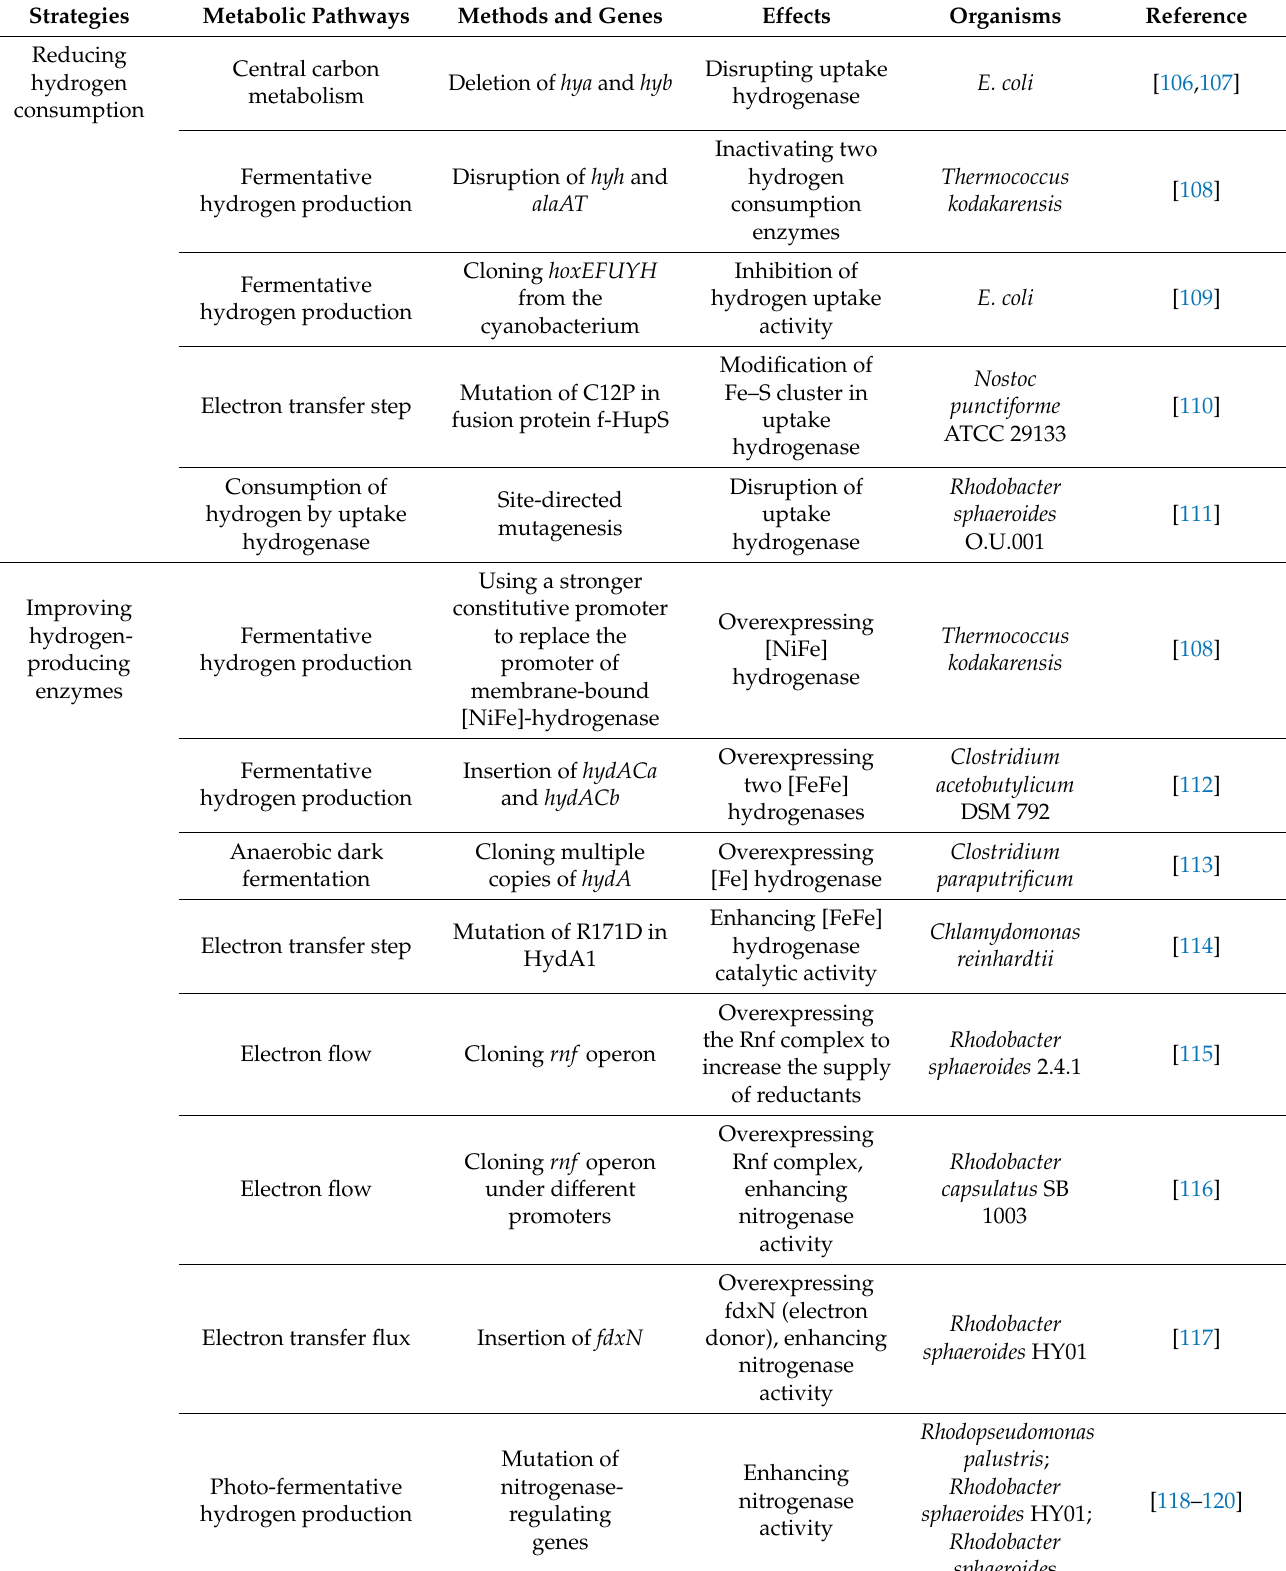
Table 3. Strategies for hydrogenases and nitrogenases metabolic